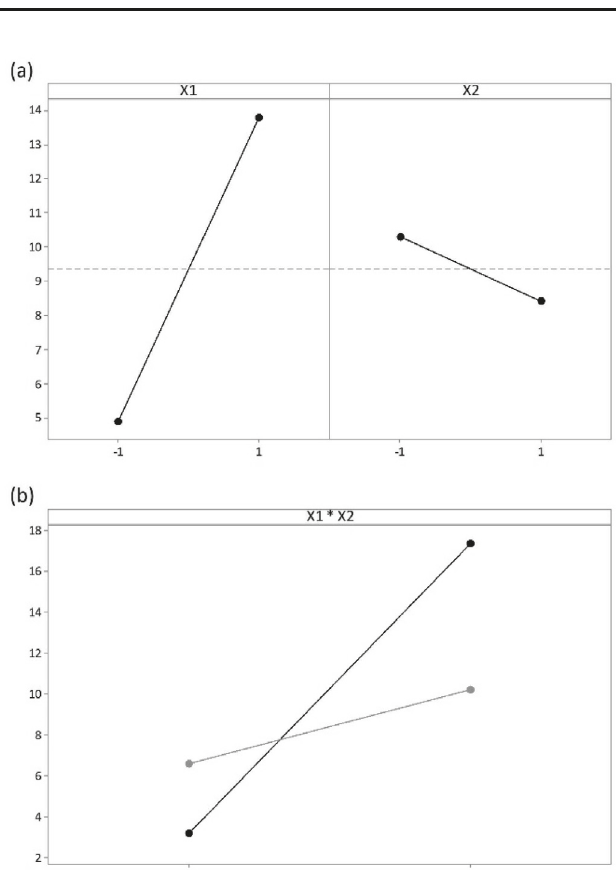
FIGURE 4 – Main effects (a) and interaction (b) plots of input factors X1 and